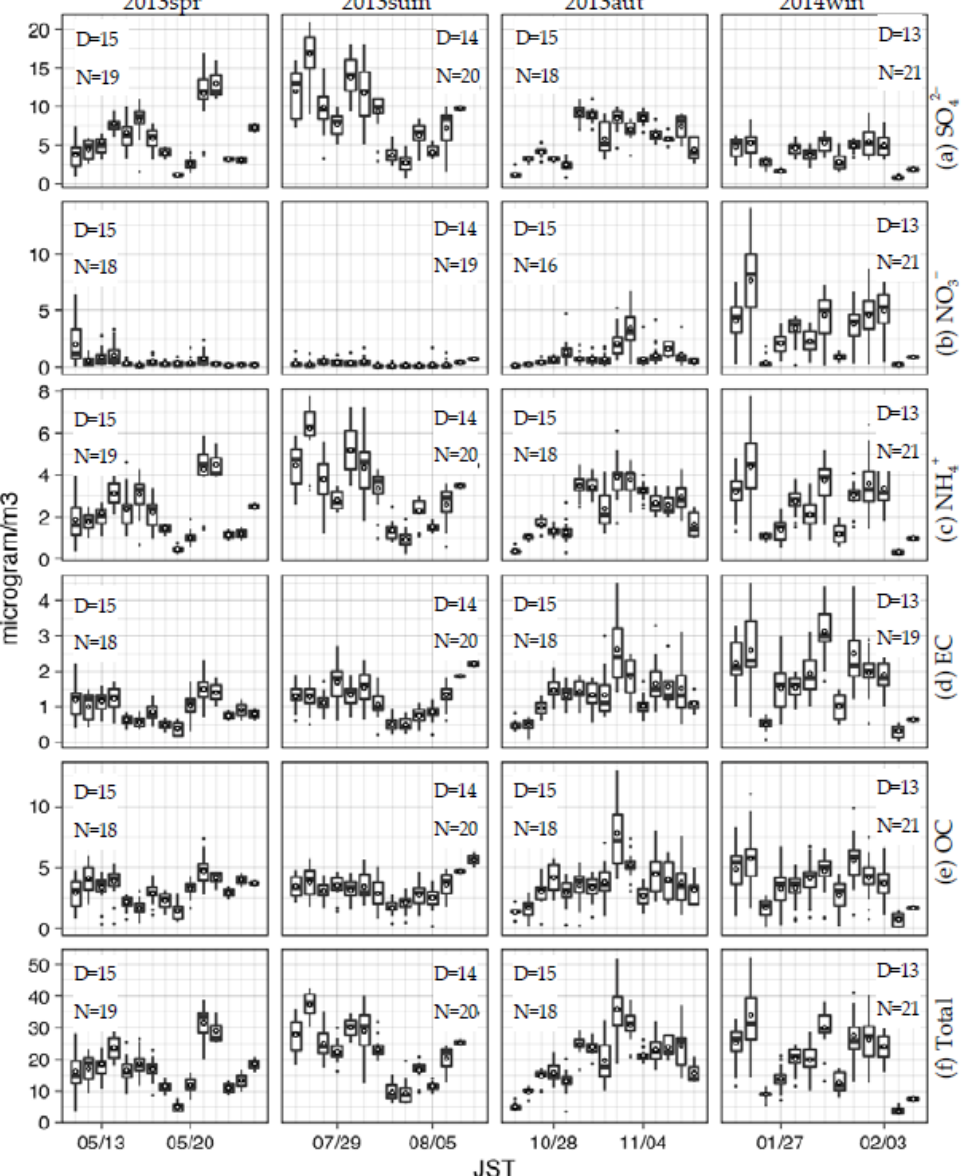
Figure 4. Box-plots of observed daily concentrations of total particulate matter with a diameter of 2.5 µm or less ( PM 2.5 ) and its components: ( a ) sulfates (SO 4 2− ), ( b ) nitrates (NO 3 − ), ( c ) ammonium (NH 4+ ), ( d ) elemental carbon (EC), ( e ) organic carbon (OC), and ( f ) total PM 2.5 mass, at AAPMSs within d03 for the four seasons. The open circles indicate spatially averages obtained from daily concentrations observed at AAPMSs within d03. The black dots indicate the outliers. The box-and-whisker and outliers represent the frequency distributions of daily concentrations observed at AAPMSs in d03. D presents the numbers of days with available observations, and N presents the number of AAPMSs.